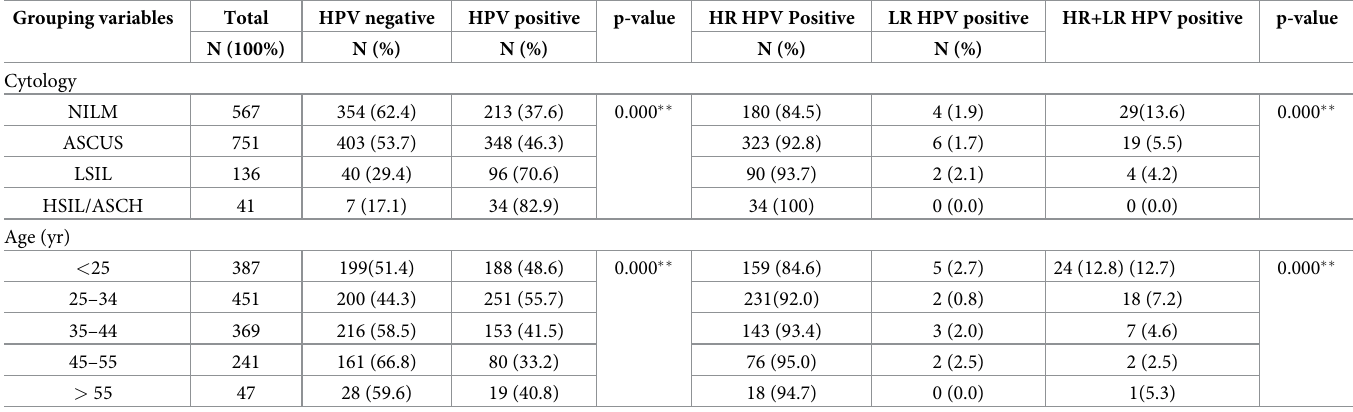
Fig 1. Prevalence of 30 genotypes of HPV among women age 18 to 65 with normal and abnormal cervical cytology. https://doi.org/10.1371/journal.pone.0249134.g001 found in women with normal cytology (14.8%) and mild abnormalities (ASCUS and LSIL), but in lower frequency in HSIL/ASCH lesions (7.4%). Among 2B, HPV 53 showed the highest frequency of 11.7%, regardless of cytological results. Unclassified HPV types were found in similar percentage in all cytology groups: 20.7%, 19.1%, 16.3% and 13.0% of NILM, ASCUS, LSIL and HSIL/ASCH, respectively (Table 3), where HPV 42 (13.0%) was consistently present. Prevalence of single and multiple HPV infection Co-infection with two or more HPV types was observed in 45.6% (347 out of 760) taking into account all HPV DNA positive samples. Women demonstrating positivity for a single HPV Table 2. HPV DNA prevalence by age and cytological